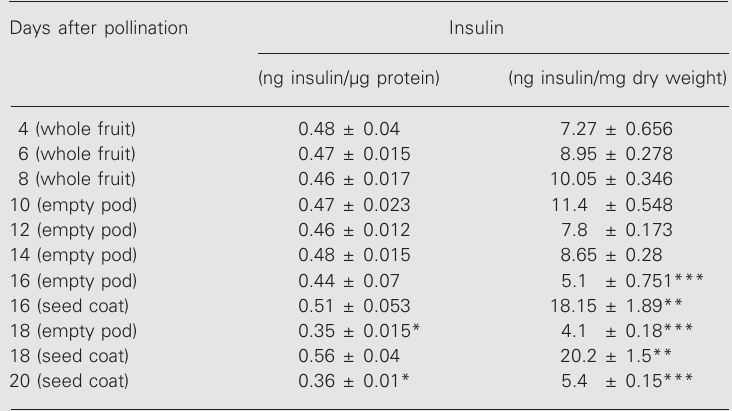
Table 2. Insulin levels per protein and dry weight of plant part in fruits of cowpea ( Vigna unguiculata ) as a function of time after